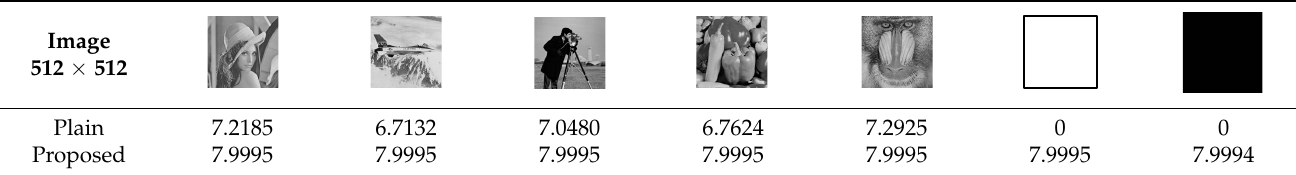
Table 6. Comparison of information entropy.